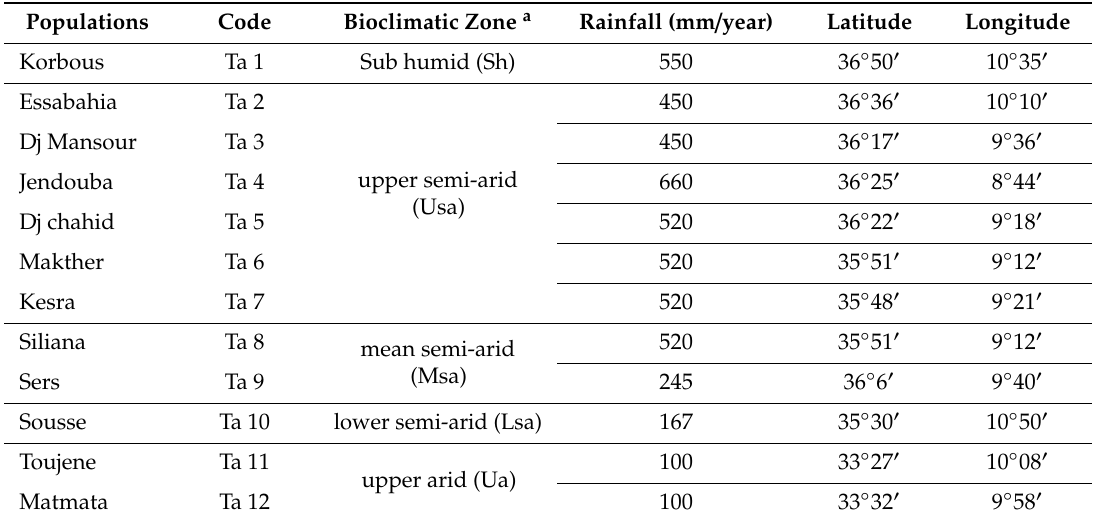
Table 1. Main ecological traits of the investigated T. algeriensis populations.